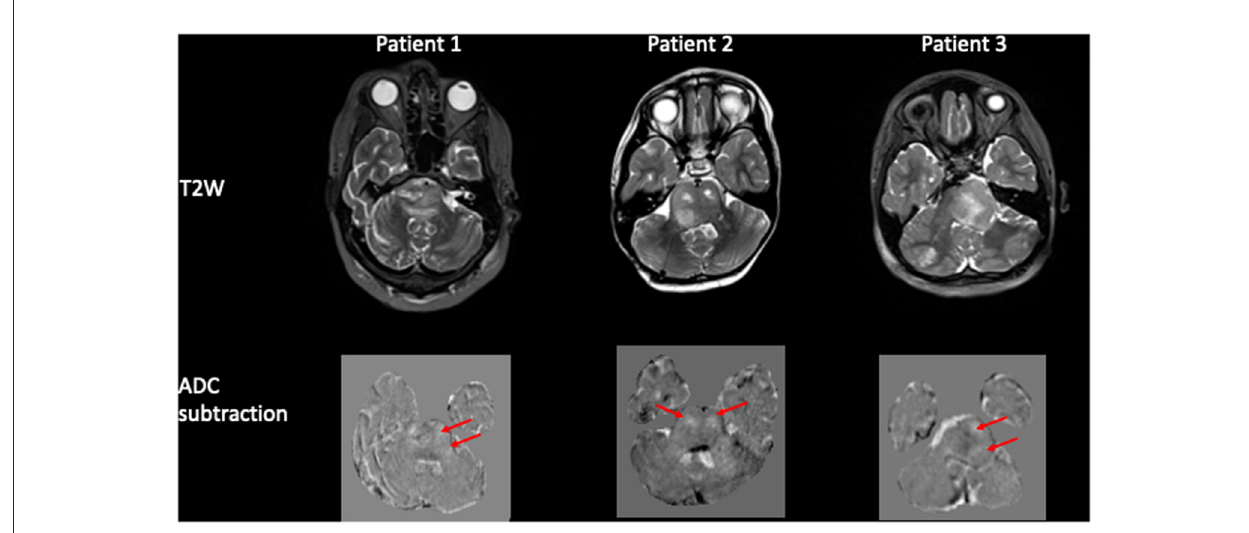
FIGURE4 Pixel-by-pixel subtraction of ADC pre and post infusion. Panel of 3 patients demonstrating the tumor pre infusion on the T2W image and corresponding pixel-by-pixel subtraction of ADC map pre and post infusion. The difference in ADC is shown as hyperintense voxels (arrowed) within the region of the